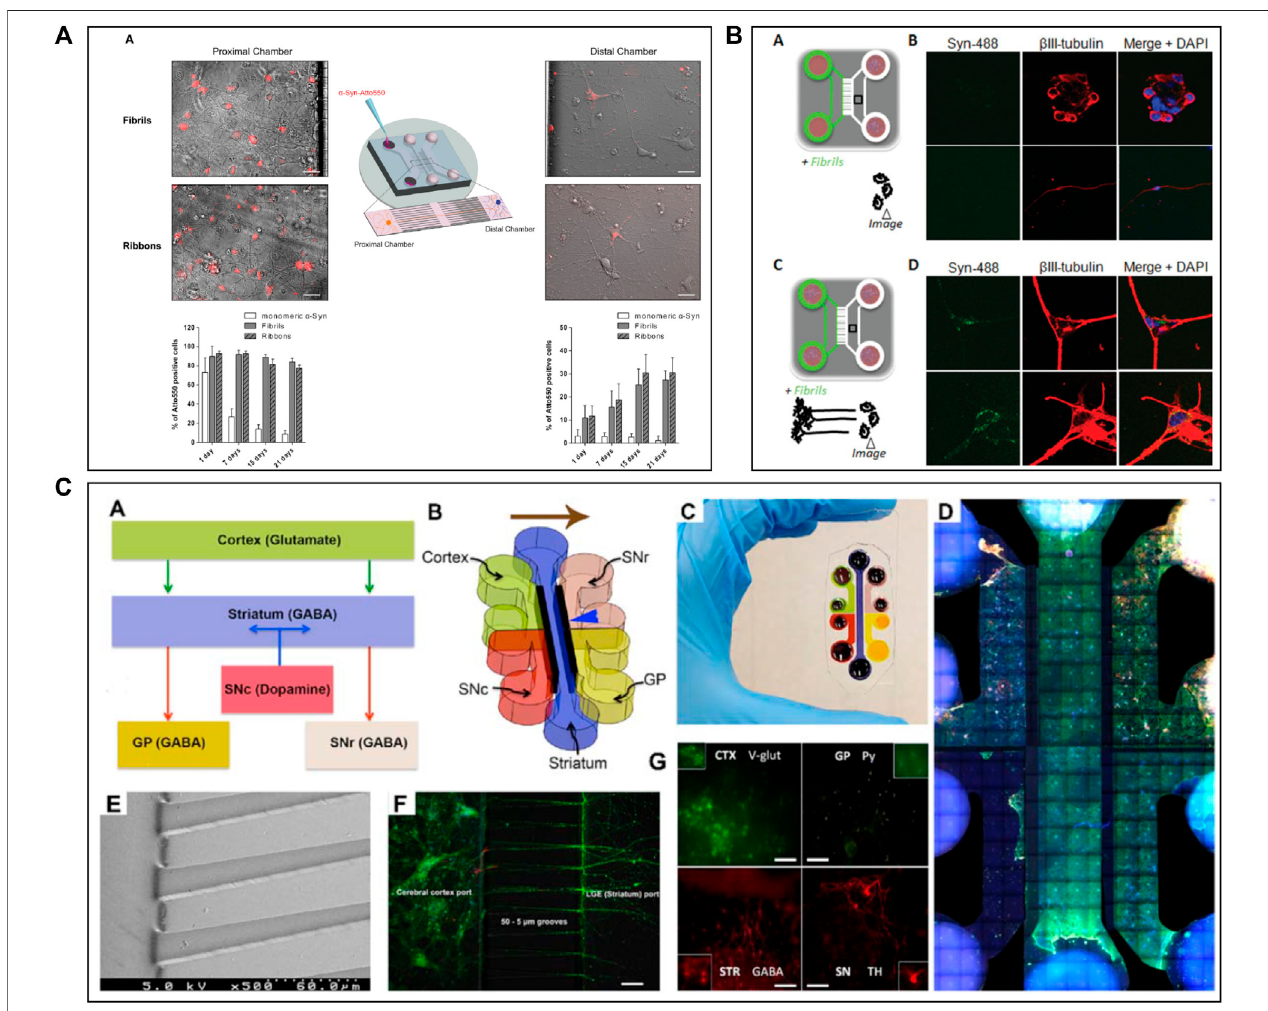
FIGURE3| Micro fl uidicdevicesusedinAmyotrophicLateralSclerosismodelling. (A) Schematicrepresentationofa2compartmentsmicro fl uidicdeviceforneuro- muscular junction (NMJ) modelling in PDMS on glass coverslips with timeline of experimental procedure in the device. Extracted from Osaki et al. (2018c)